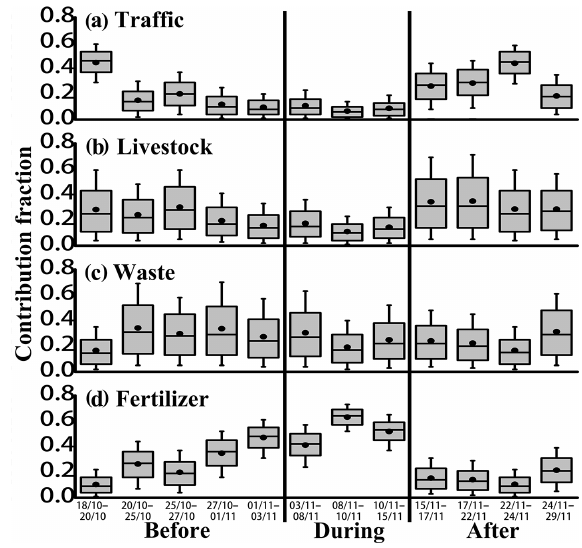
Figure 3. Time series of the box-whisker plots of the contribution fraction of ambient NH 3 from different sources estimated from the IsoSource model. The box boundaries represent the 25th and 75th percentile, the horizontal line is the median, and the whiskers mark the 10th and 90th percentiles. The dots denote the mean values of the distribution.